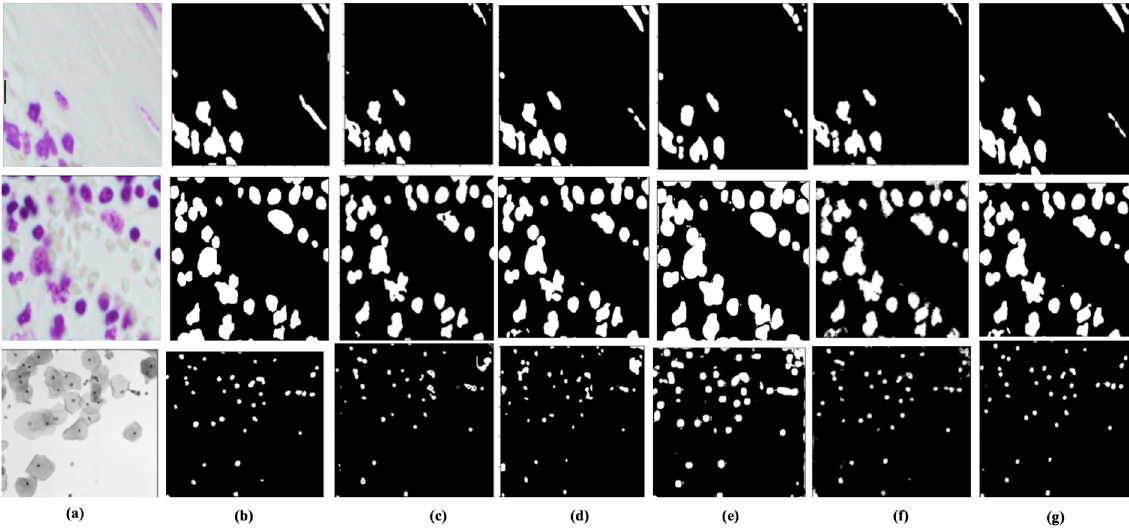
Figure 11. Visual comparisons among the segmentation models on the nuclei cell segmentation dataset: ( a ) the original images; ( b ) the ground truth; ( c ) U-Net; ( d ) Depth-Separable U-Net; ( e ) Attention U-Net; ( f ) Inception U-Net; and ( g ) the proposed model results.